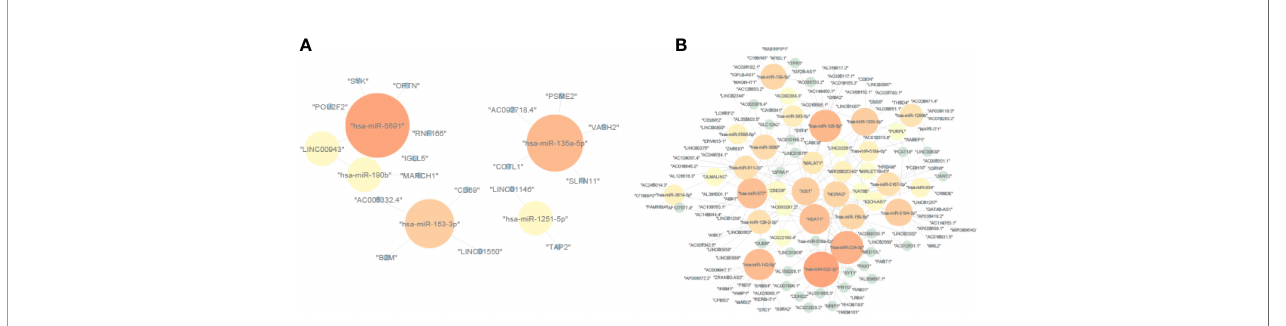
FIGURE 3 | The ceRNA networks. (A) CD8 T-cell-positive ceRNA network constructed by UmRNAs, DmiRNAs, and UlncRNAs. (B) CD8 T-cell-negative ceRNA network constructed by DmRNAs, UmiRNAs, and DlncRNAs. The upregulation mRNAs (UmRNAs), downregulation mRNAs (DmRNAs), upregulation miRNAs (UmiRNAs), downregulation miRNAs (DmiRNAs), upregulation lncRNAs (UlncRNAs), and downregulation lncRNAs (DlncRNAs) were de fi ned by their expression values in the high CD8 T-cell